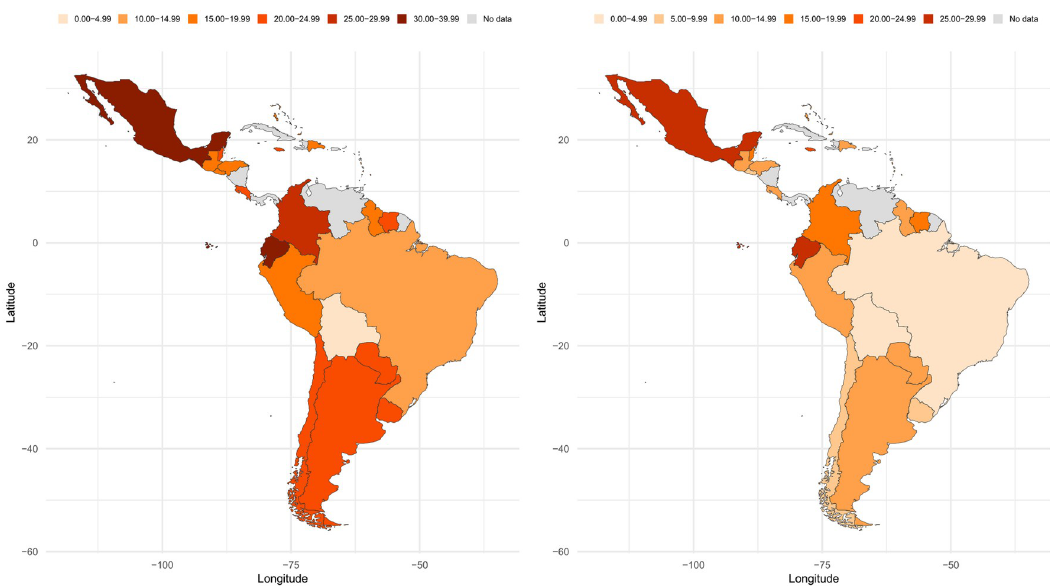
Fig 2. Prevalence map of meeting 2010 WHO PA guidelines among Latin-American children and adolescents. Left: Boys; Right: Girls. These maps were rendered in RStudio 1.4.1103 using the rworldmap [25] and ggplot2 [26] R packages.